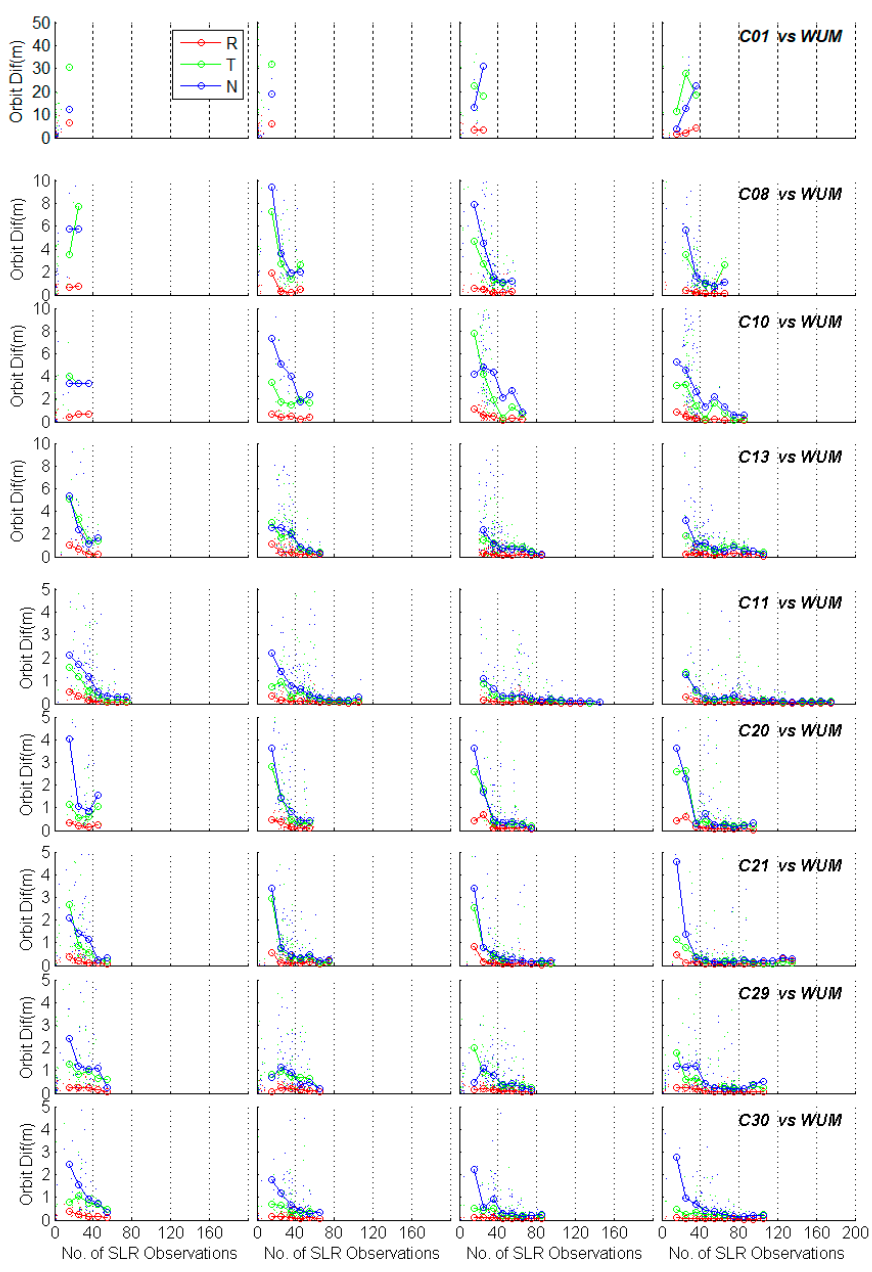
Figure 16. The dependency of median RMS on the number of SLR observations. The red, green, and blue dots, as well as dotted lines, represent values in the R, T, and N directions respectively. In particular, the hollow circle dotted line refers to the median RMS with a step size of 10.